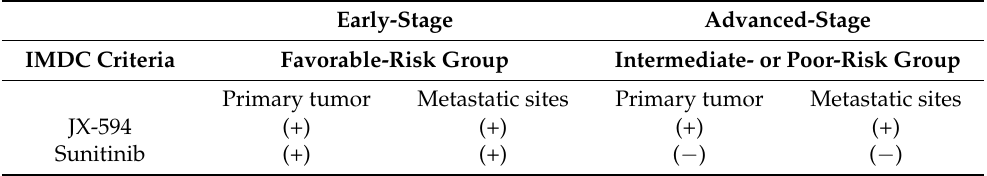
Table 1. Comparison of therapeutic efficacy of JX-594 and sunitinib monotherapy in early- and advanced-stage metastatic renal cell carcinoma